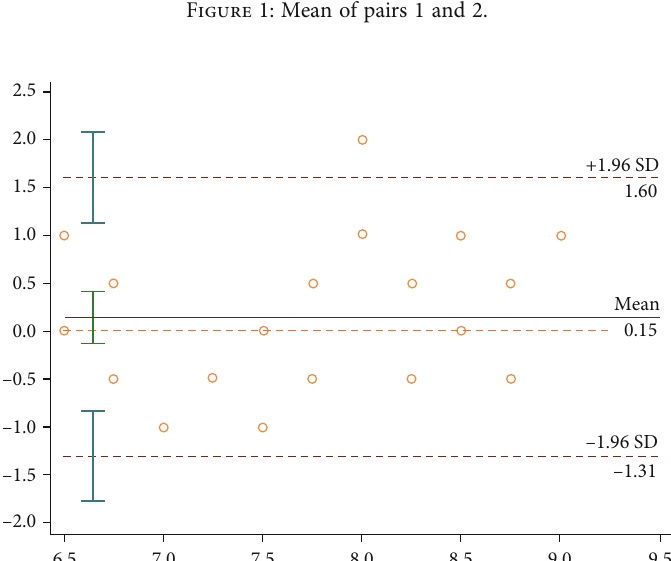
Figure 1: Mean of pairs 1 and 2.